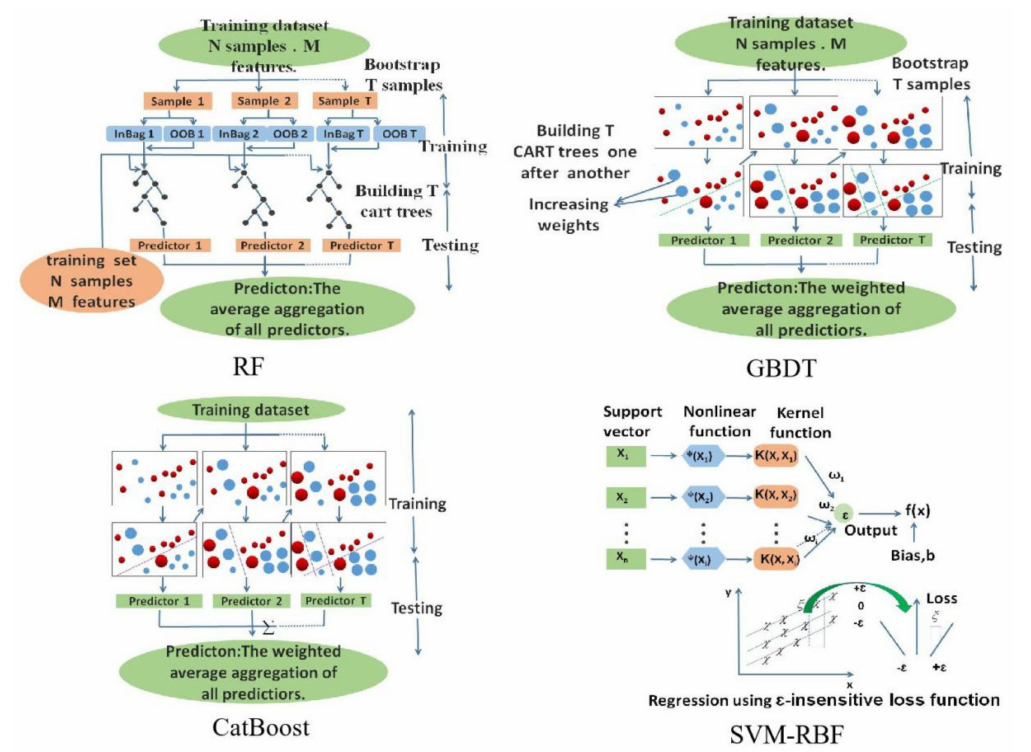
Figure 2. General structure of the proposed